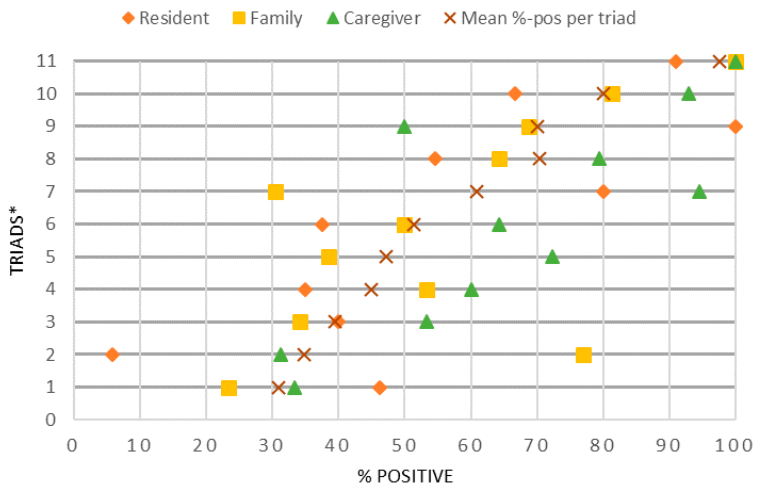
Figure 1. %-Positive coded segments of each resident, family, and caregiver per triad. * Each row represents one completed Connecting Conversation triad, presenting the %-positive for the resident, family, caregiver, and the mean %-positive for these three.